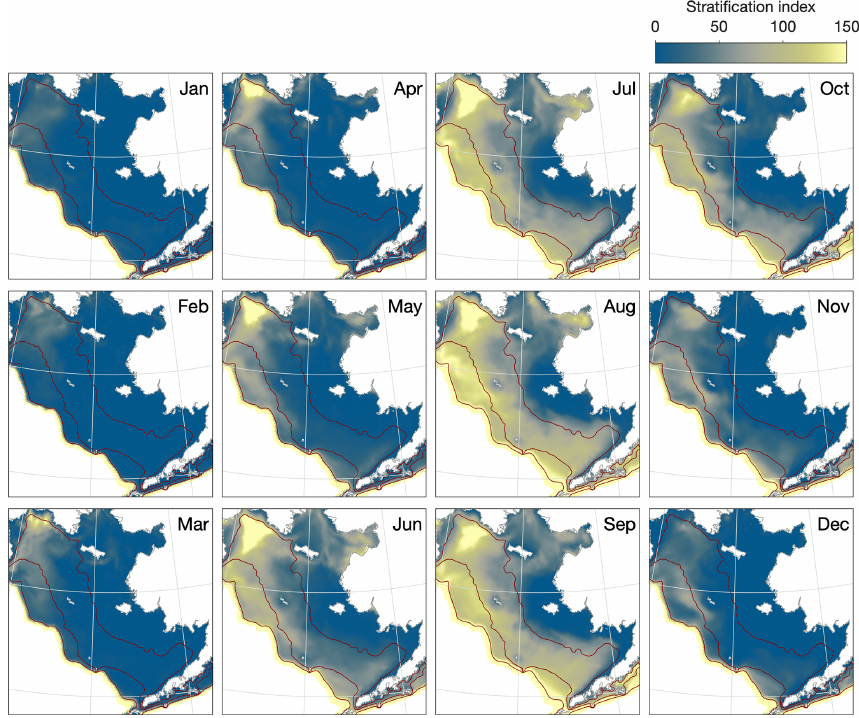
Figure 7. Monthly climatologically averaged simulated stratification across the Eastern Bering Sea shelf. Dark red lines indicate the pri- mary 50, 100, and 200m contour lines based on the model shelf